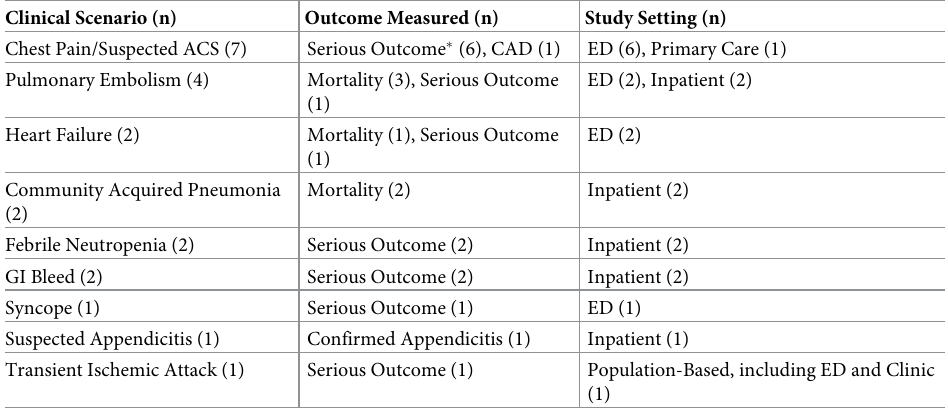
Table 1. Clinical scenario, outcome measured, and study setting for clinical risk scoring